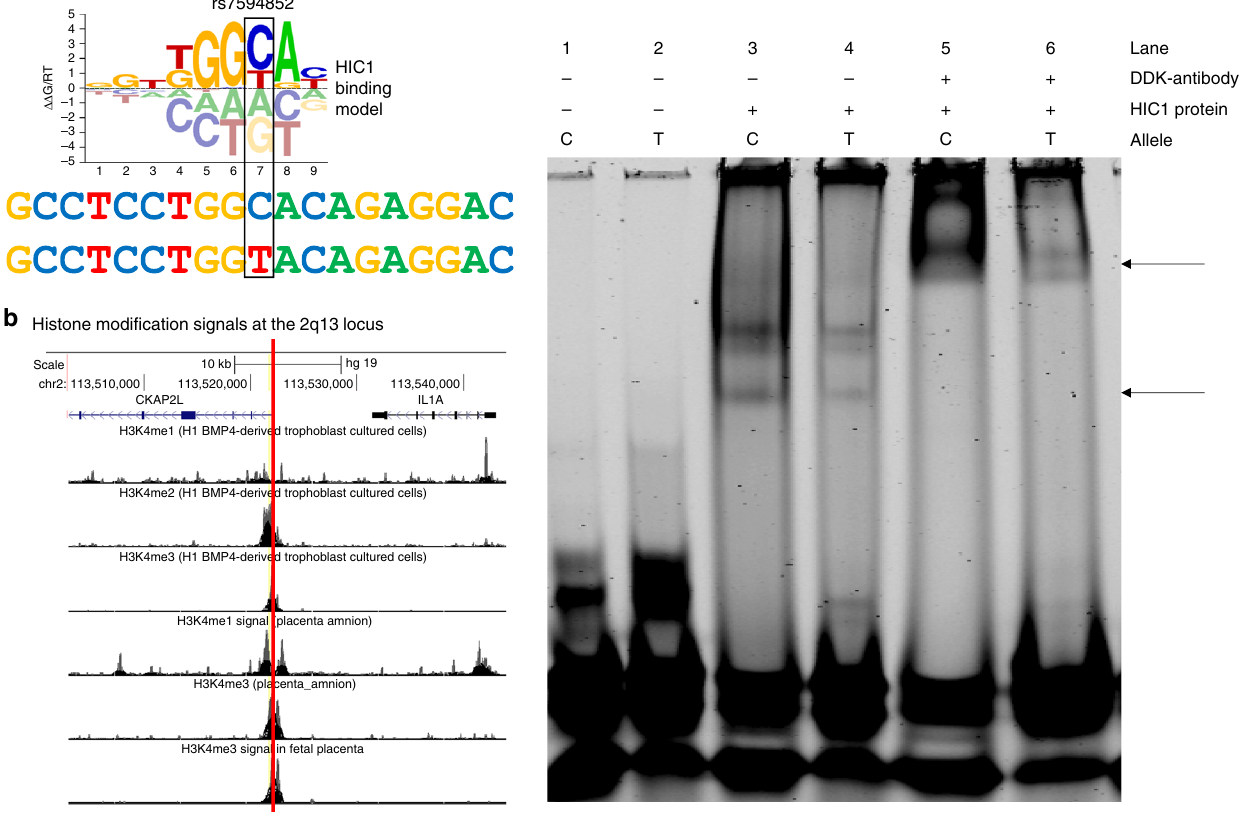
Fig. 3 HIC1 binding at the 2q13 locus. a The rs7594852-C allele creates a stronger binding site for the hypermethylated in cancer 1 (HIC1) protein. The sequence logo of the HIC1-binding motif shows the DNA binding preferences of HIC1. Tall nucleotides above the dashed line indicate DNA bases that are preferred by HIC1, whereas bases below the dashed line are disfavored. The y -axis indicates the relative free energies of binding for each nucleotide at each position. The height of each nucleotide can be interpreted as the free energy difference from the average ( ΔΔ G ) in units of gas constant ( R ) and temperature ( T ). The DNA sequence fl anking the rs7594852-C allele is shown directly below, with the alternative rs7594852-T allele shown at the bottom. The rs7594852-T allele changes the HIC1 binding site sequence from C (most favored) to T (less favored). b UC Santa Cruz Genome Browser screenshot depicting the rs7594852 locus. The purple ( CKAP2L ) and black ( IL1A ) graphics at the top indicate the locations of exons (columns), untranslated regions (rectangles), and introns (horizontal lines), with arrows indicating the direction of transcription. The red vertical line indicates the position of rs7594852, which overlaps strong signals obtained from chromatin immunoprecipitation sequencing (ChIP-seq) experiments (indicating histone modi fi cation by mono-, di-, or trimethylation of histone H3 on lysine 4; H3K4) in trophoblast cultured cells, placental amnion, or fetal placenta. c Experimental validation of allele-dependent binding of human puri fi ed recombinant HIC1 protein with a c-Myc/DDK tag to rs7594852 and fl anking sequence via electrophoretic mobility shift assay (EMSA). Arrows indicate allele-dependent binding of HIC1 (bottom arrow) and a supershift of the protein – DNA complex induced by the binding of the anti-DDK antibody to the complex (top arrow). The presence of multiple bands in lanes 3 and 4 is likely due to the presence of multiple HIC1 isoforms. Source data are provided as a Source Data fi